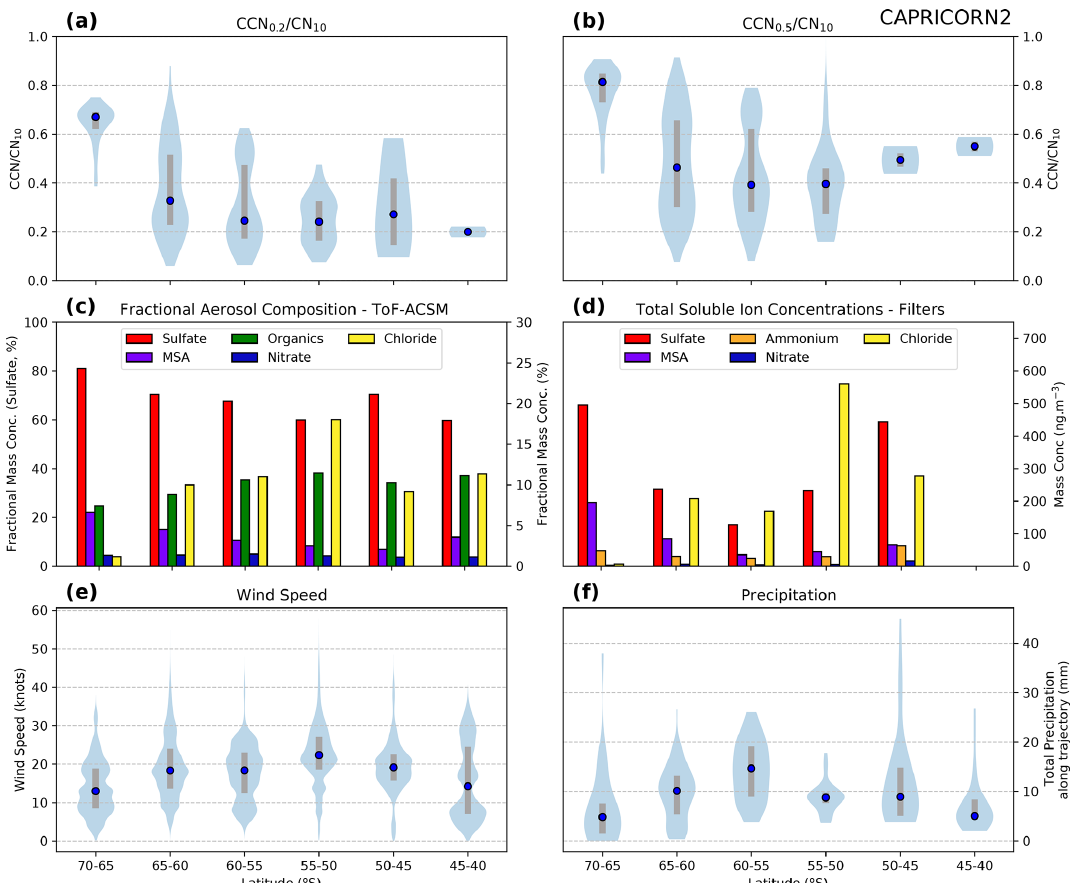
Figure 3. Latitudinal distributions for parameters measured during CAPRICORN2 highlighting the aerosol composition and source and sink mechanisms. The CCN / CN 10 ratios for 0.2% and 0.5% supersaturation are shown in (a) and (b) , respectively; the major aerosol chemical components from the ToF-ACSM in (c) ; and the total soluble ions from PM 1 filters in (d) . Panel (e) shows the wind speed measured onboard the vessel, and (f) shows the total precipitation calculated using ERA5 reanalysis data along the backward trajectory for each measurement. Note that in (c) , the sulfate is split to the left axis to enable better visibility of trends of other